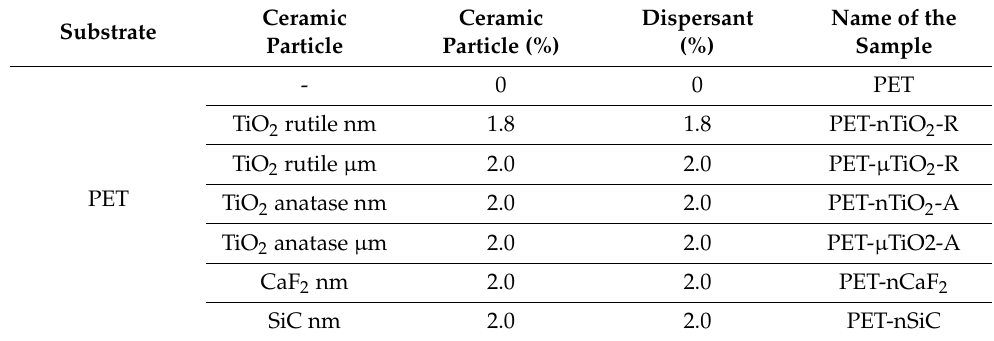
Table 1. Multifilament yarns used in this study.